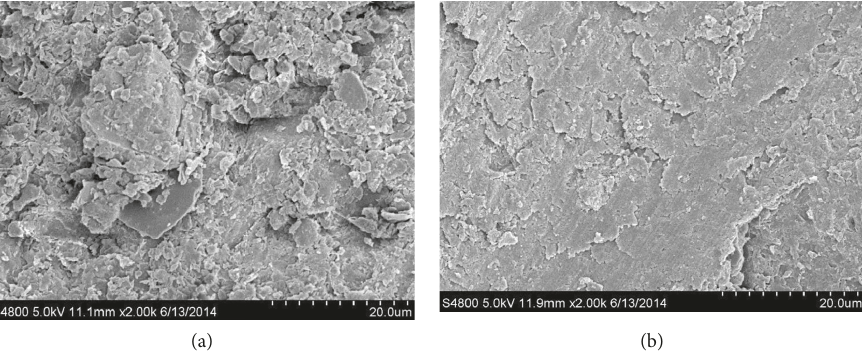
Figure 6: Comparison of the microstructures of rock masses in the weathered zone (2000 magnifications, 20 με ): microstructure of the samples in the (a) unreinforced section and (b) after grouting